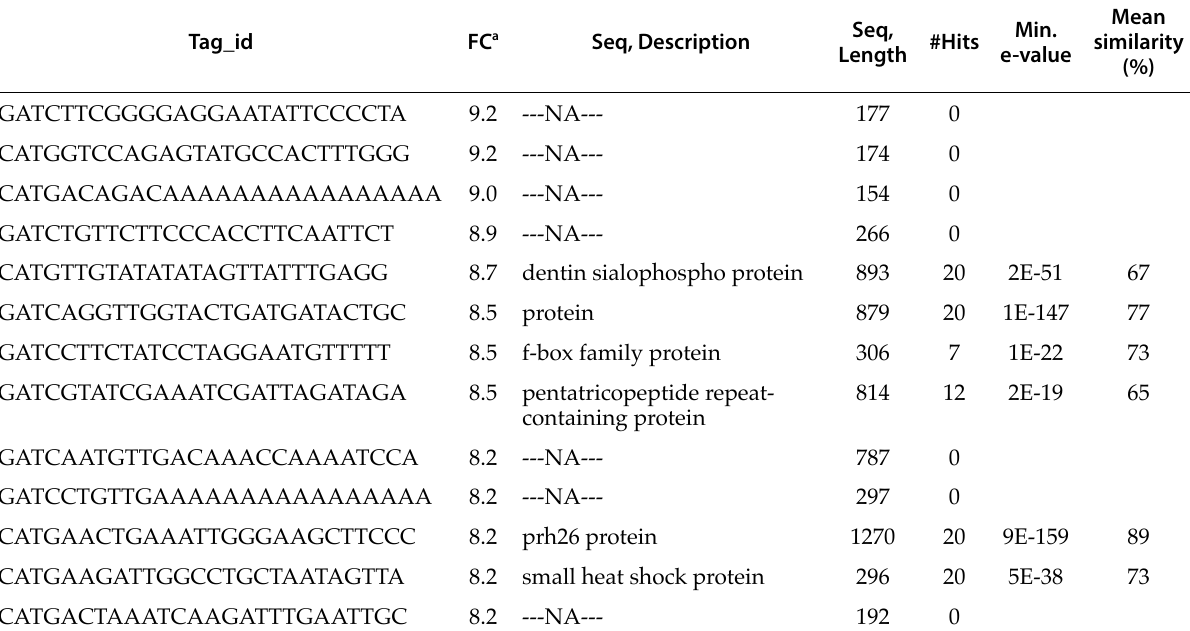
Table 3. Top 40 down-regulated